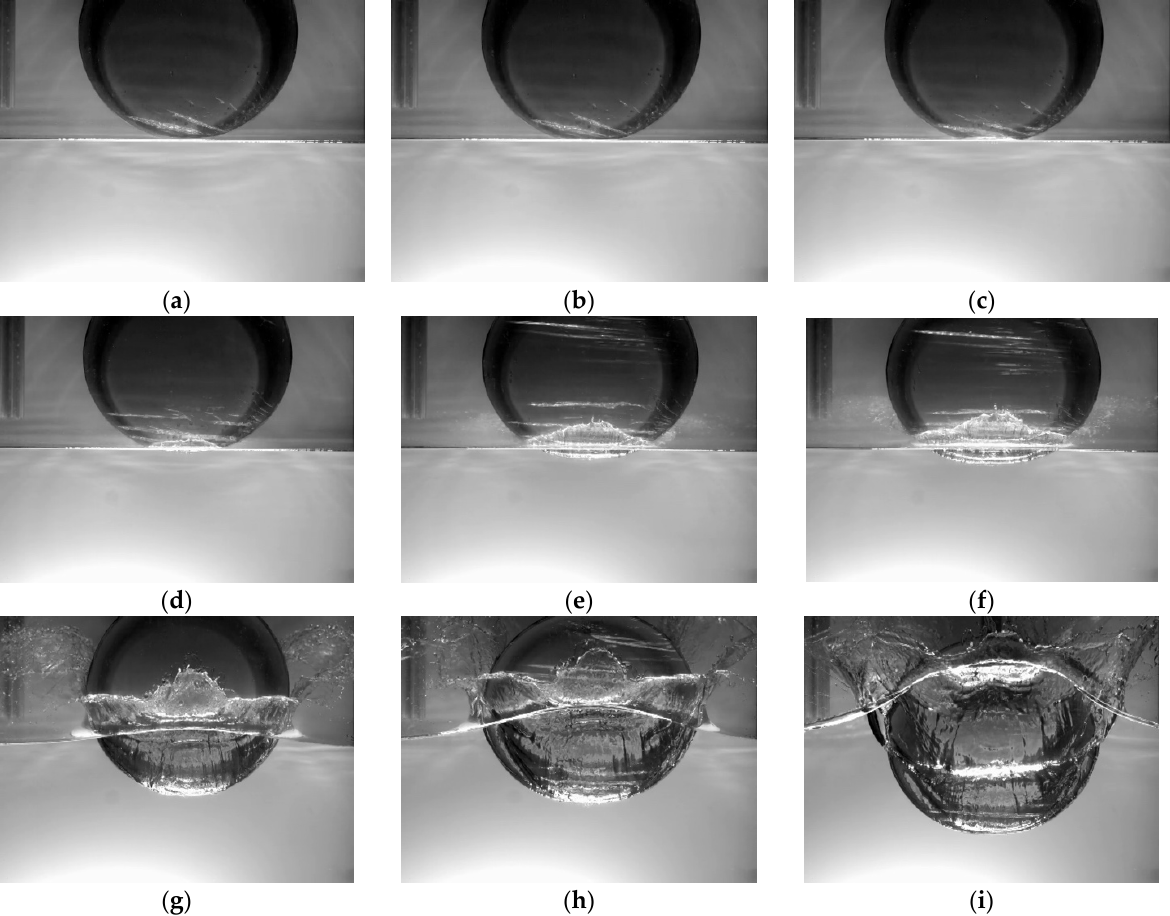
Figure 4. Evolution of cylinder water impact. The frames are acquired through the Phantom ® Miro 110 high speed camera. The panel is grouped according to the three phases of cylinder penetration through the free surface: frames ( a – c ): water impact and initial stages of cylinder deformation; frames ( d – f ): macroscopic deformation of the cylinder, during free surface penetration; pile-up and water jet formation [25]; frames ( g – i ): formation of the water-cavity [25]. Cylinder water impact video is available online (see Supplementary Materials Video S1).